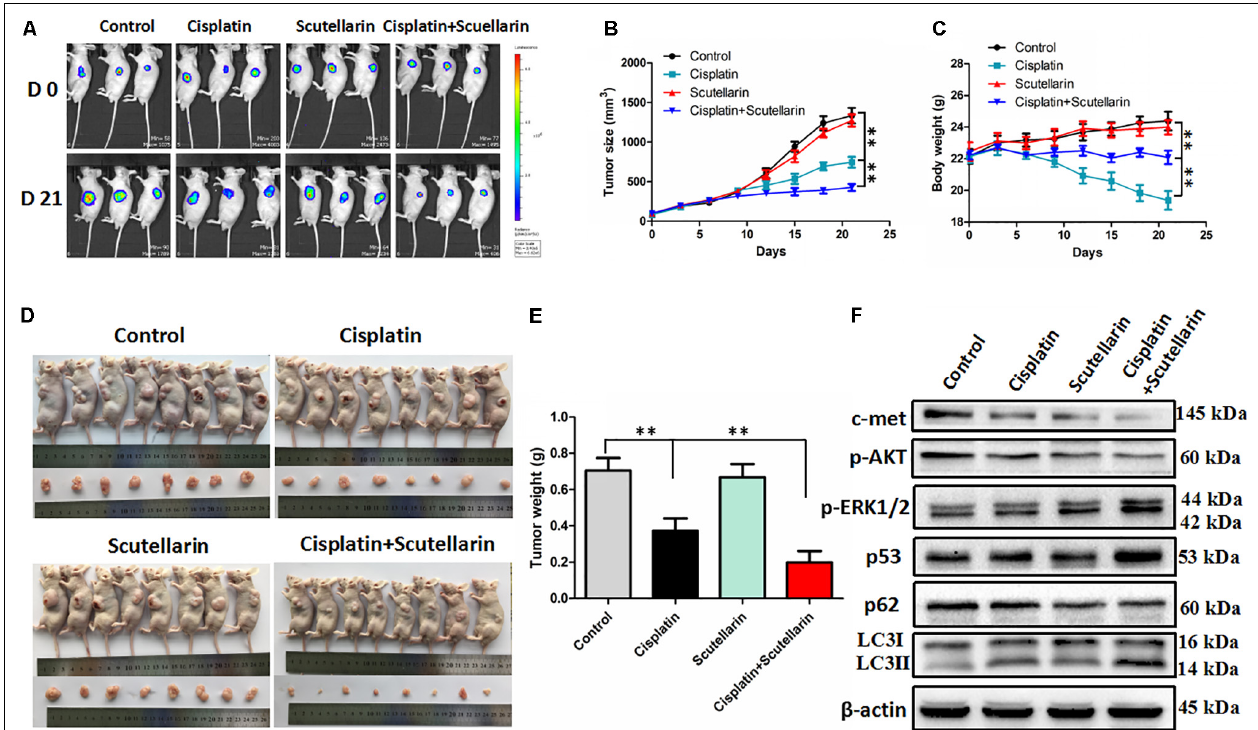
FIGURE 6 | Scutellarin enhanced antitumor efficacy of cisplatin in vivo . The A549/DDP-Luc cells were subcutaneously implanted BALB/c nude mice, and the mice were treated with cisplatin with or without scutellarin. (A) Tumor growth was monitored by IVIS, representative bioluminescence images of tumor in mice are shown. (B) The tumor dimensions were measured per 3 days using a digital caliper, tumor size in each group is shown. (C) Body weight of each group ( n = 8). (D) After treatment for 21 days, mice were humanely euthanized, and the tumor tissues were subsequently harvested. (E) Tumor weight of each group ( n = 8). (F) The expression levels of LC3, p62, p53, p-ERK1/2, p-AKT, c-met in mice tumor were detected by western blot analysis. Data are representative of three independent experiments (mean ± SEM). ∗∗ p <